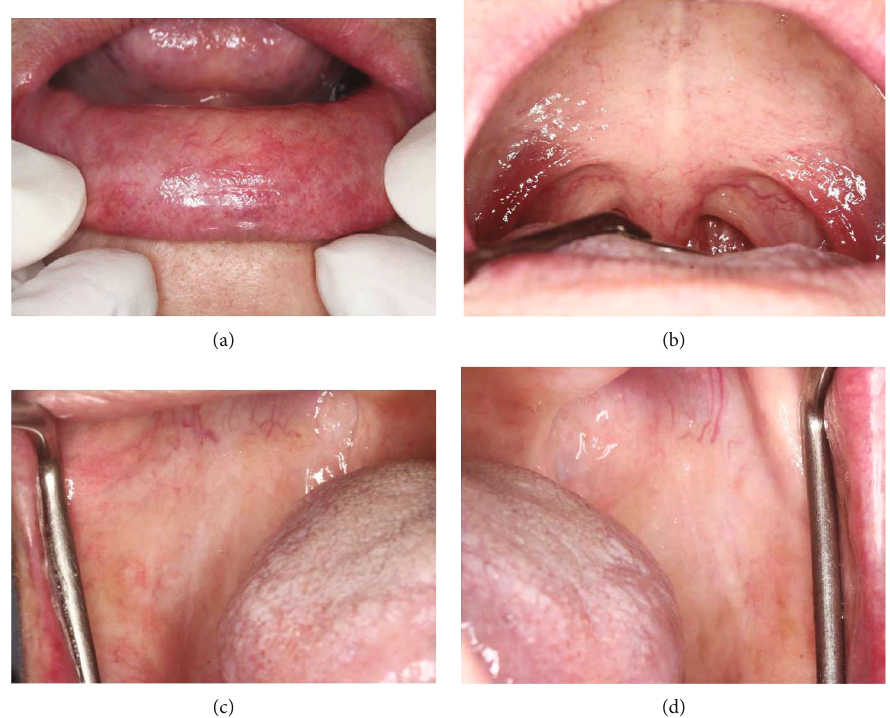
Figure 4: Clinical illustration after 8-month treatment period; complete resolution of super fi cial mucoceles at the lower labial mucosa (a) and the soft palate (b). Remission of OLP lesions at the bilateral buccal mucosa (c,